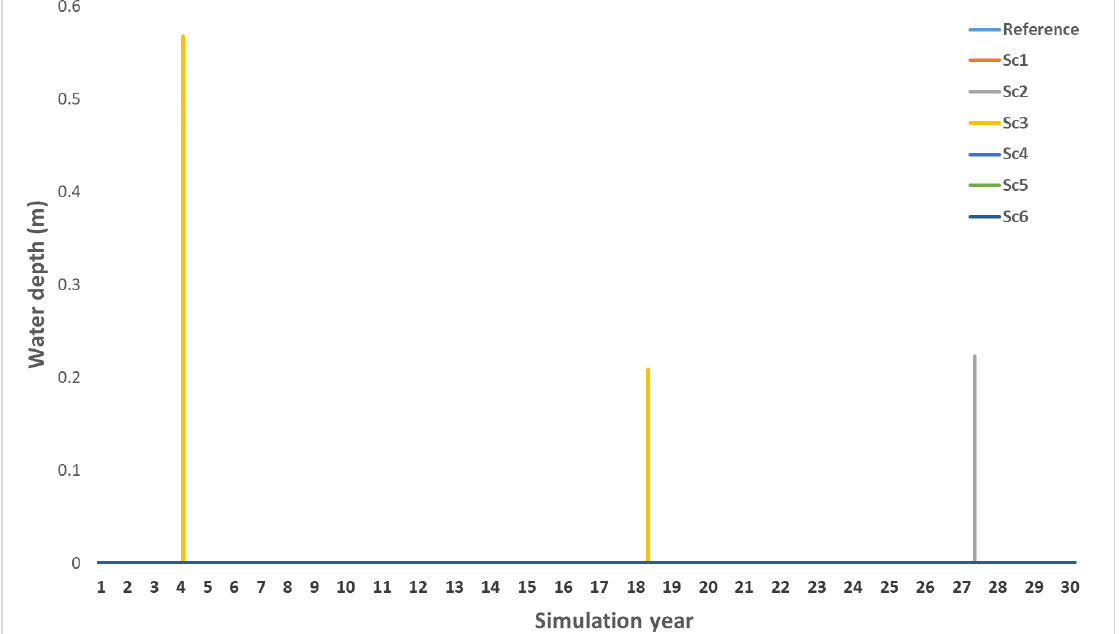
Figure 6. Results of the climate change scenario flood modeling. Water depth at the Agora site (maximum water depth site; see Figure 2).